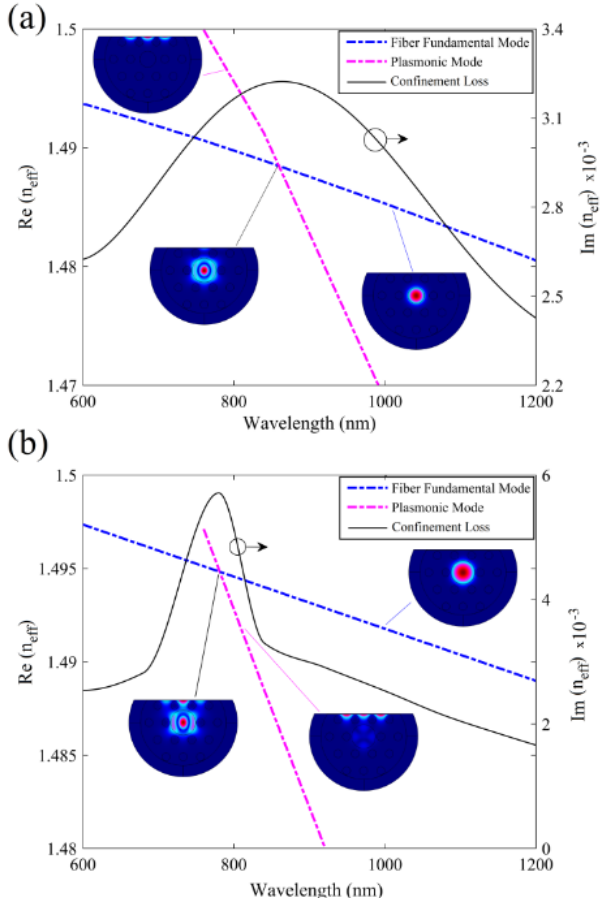
Figure 16. Real and imaginary parts of e ff ective index of fiber mode and plasmonic mode in a D-shaped plasmonic fiber-optic biosensor as a function of wavelength in ( a ) with a core size of d c / Λ = 0.46 and ( b ) with a core size of d c / Λ = 0.7. The other design parameters are n analyte = 1.5, d / Λ = 0.23, Λ = 6 µ m and t = 50 nm. Insets show field distribution at di ff erent points in spectra for fiber, plasmonic, and the coupled core-plasmonic modes. Reproduced with permission from Reference [37], Copyright 2019, IEEE.